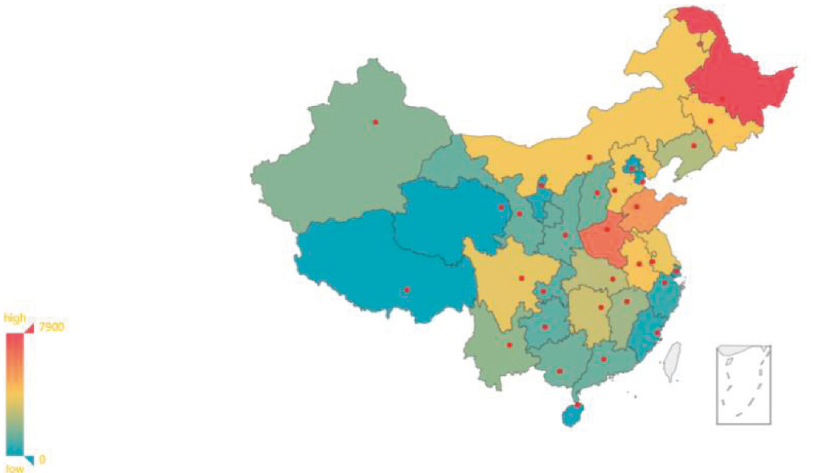
Figure 5: Heatmap of China’s food security